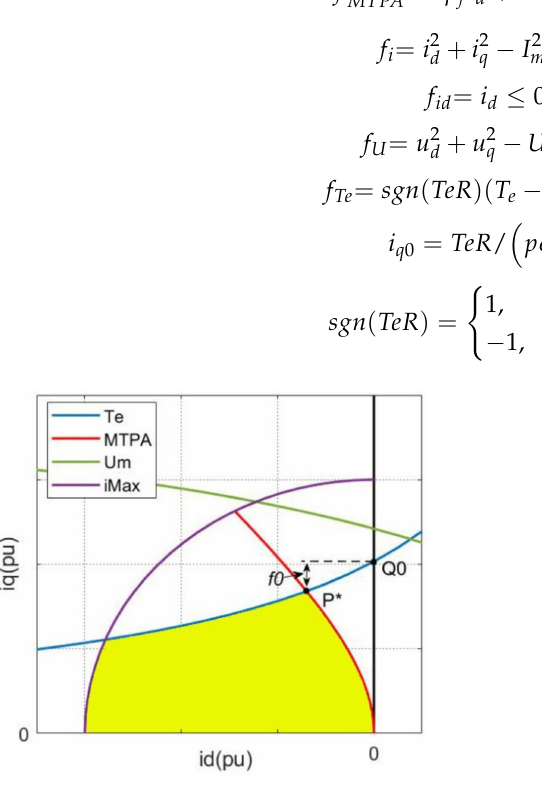
Figure 5. Equivalent optimization problem, TeR (cid:54) =